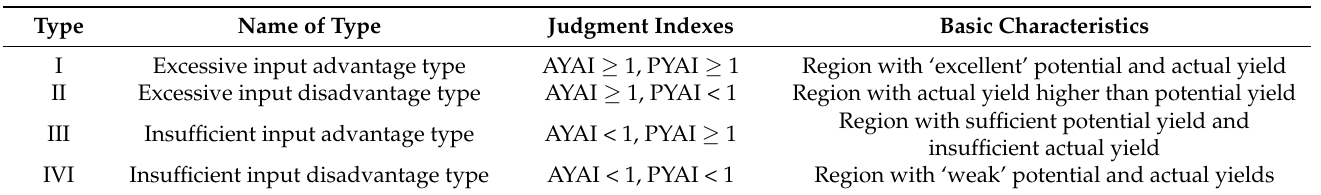
Table 1. Potential yield advantage and actual yield advantage of crop